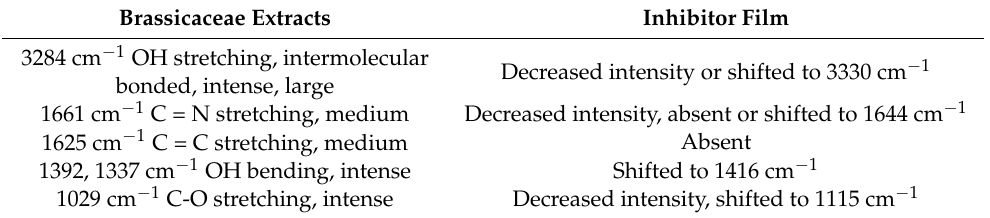
Table 7. The changes in the FT-IR spectra of inhibitor film compared to Brassicaceae extracts. Brassicaceae Extracts